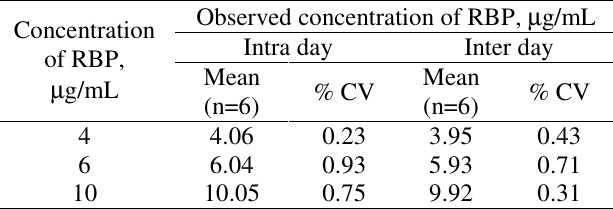
Table 2. Inter and Intra day precision for RBP assay in pharmaceutical dosage form by the proposed HPLC method